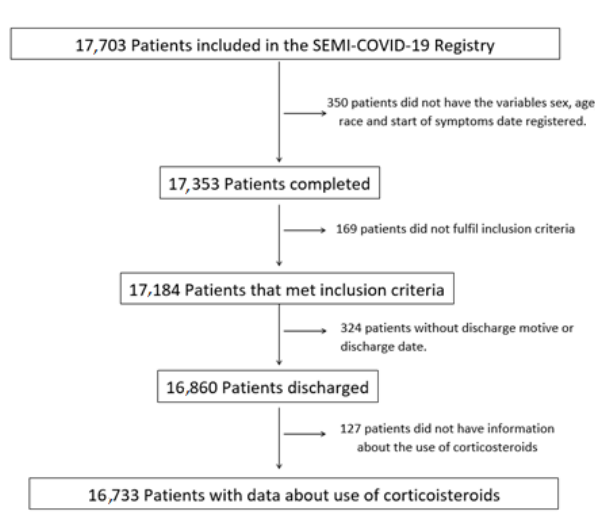
Figure 1. Patient selection flowchart.